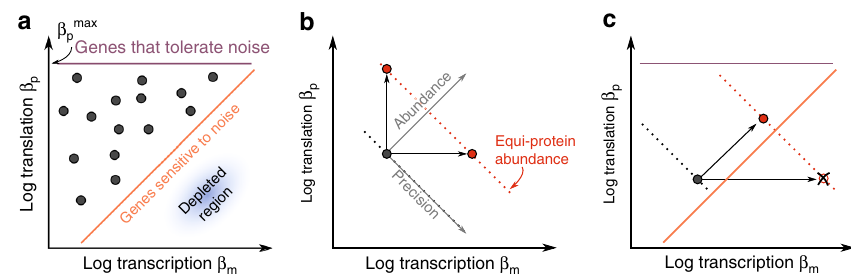
Fig. 5 The precision-economy trade-off suggests rules for choosing transcription and translation rates and for selecting regulatory strategies. a Due to the precision-economy trade-off, low β p / β m is preferred for genes that are sensitive to noise. In log-log scale, low β p / β m corresponds to a diagonal line. On the other hand, high β p / β m is preferred for proteins that tolerate noise. Because translation rates have an upper limit β max p , genes with highest β p / β m are found on a horizontal line. b Regulatory strategies that lead to the same protein abundance differ in how they impact precision. Upregulating transcription simultaneously increases protein abundance and precision. On the other hand, upregulating translation increases protein abundance while decreasing precision. Transcription control is thus advantageous assuming that precision is desirable. c When protein abundance changes by a large amount, pure transcription regulation can put the gene in the sub-optimal, depleted region. This can be avoided by co-regulating transcription and translation. See also Supplementary Fig.